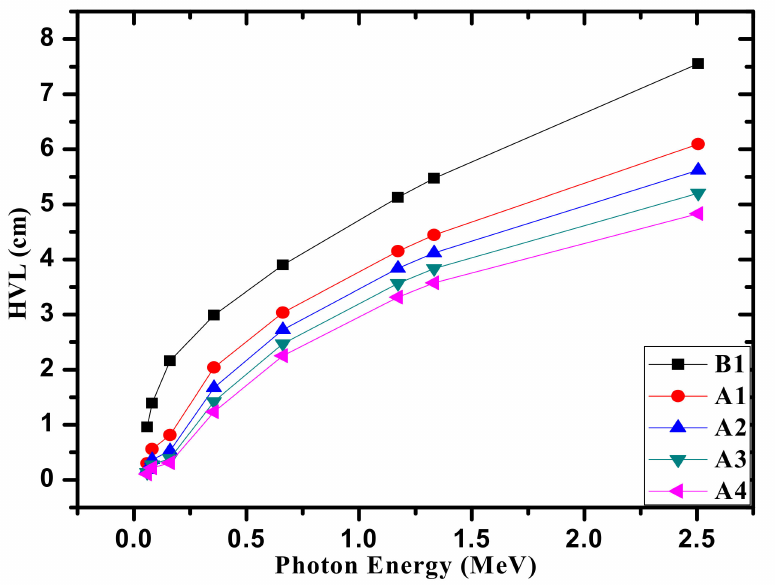
Figure 4. The HVL for the fabricated